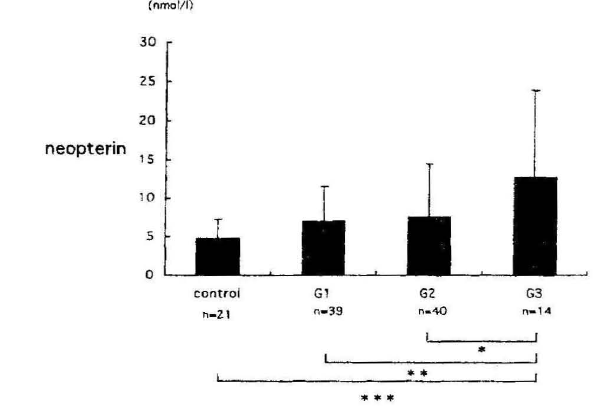
Figure 2. Mean serum concentrations of neopterin in normal individuals and patients with renal cell carci nomas of grade 1 (Gl), grade 2 (G2), and grade 3 (G3). Values are expressed as mean ± SD. *p<O.OS . **p<O.OOS.